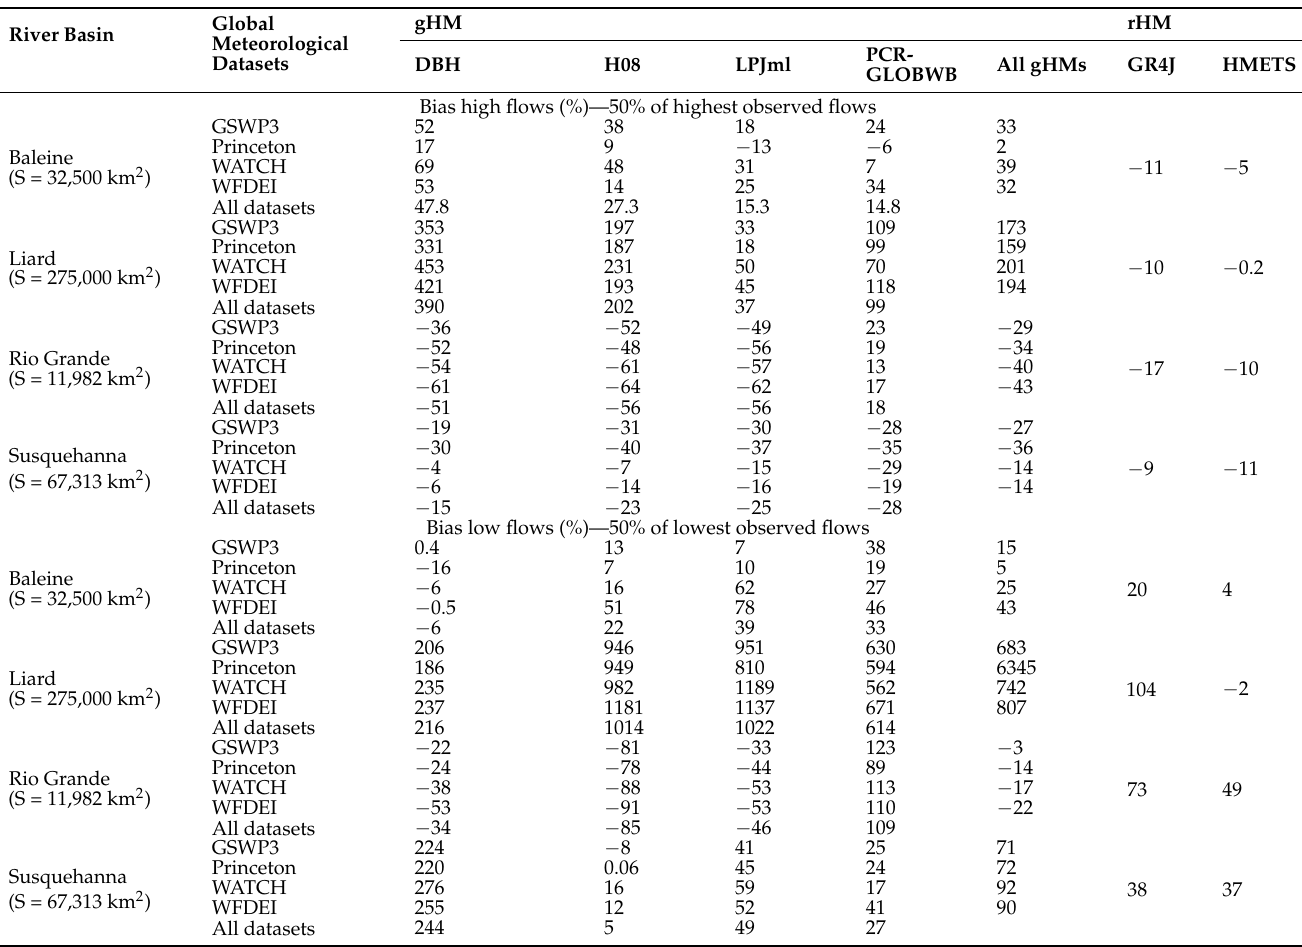
Table 5. PBIAS values (%) of high and low flows computed for each gHM–climate–dataset combination and the two rHMs for the four catchments over the 1971–2010 period. The satisfactory PBIAS values are in bold (PBIAS ≤ ± 25%; see Section